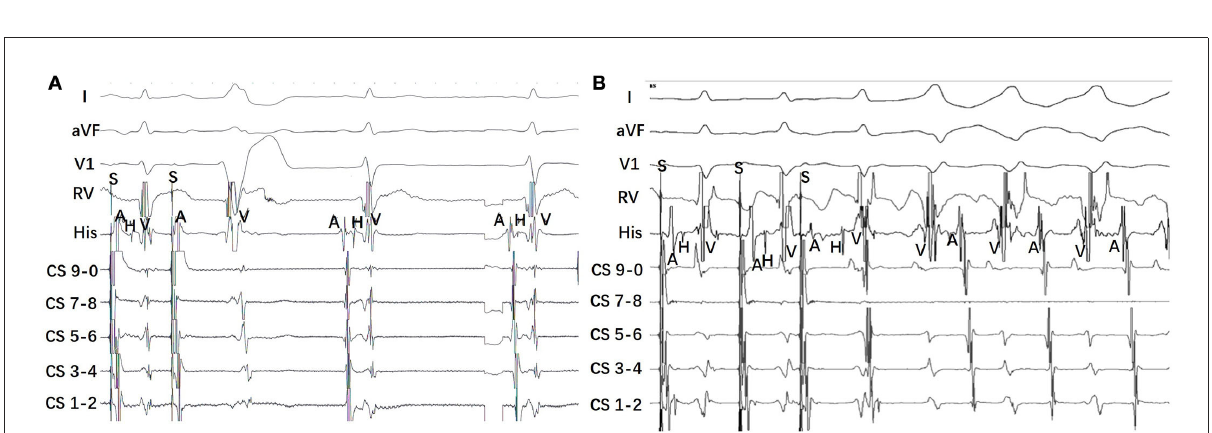
FIGURE2 Representative intracardiac electrocardiogram from a patient with right-sided MAP and a patient with left-sided MAP. (A) Atrial programmed atrial stimulation (S1S1) induced a pre-excitation of QRS complex with LBBB pattern. It presents antegrade long conduction with lengthening of the A-H interval and A-V interval, a contemporary shortening of the H-V interval. (B) Atrial programmed stimulation (S1S1) induced tachycardiac with a broad QRS complex. The tachycardia has an RBBB pattern, long AV interval, and short VA interval. The earliest atrial activation was detected at the His-bundle electrodes during the